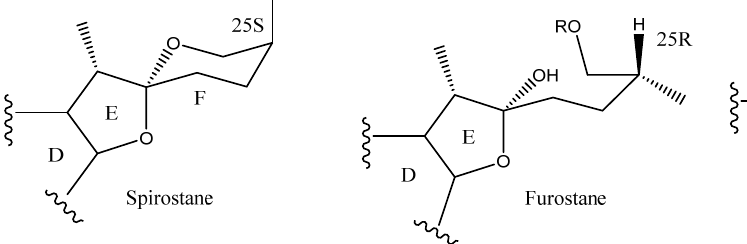
Figure 4. Structure of steroidal aglycones on the C-22.